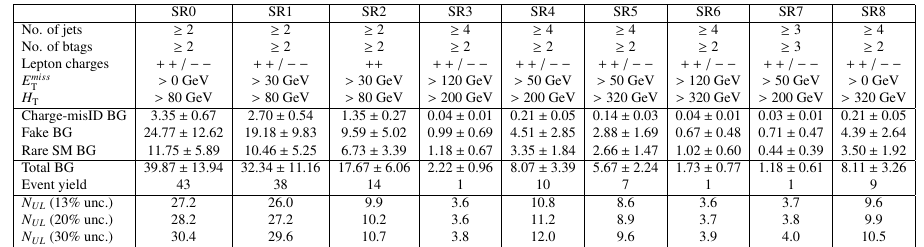
Figure 1. Exclusion (95 %C.L.) in the m ( (cid:101) χ 0 virtual stops (left). Exclusion (95 %C.L.) in the m ( (cid:101) χ ± These models have more than two mass parameters, and cannot be fully represented in a two dimensional plot.